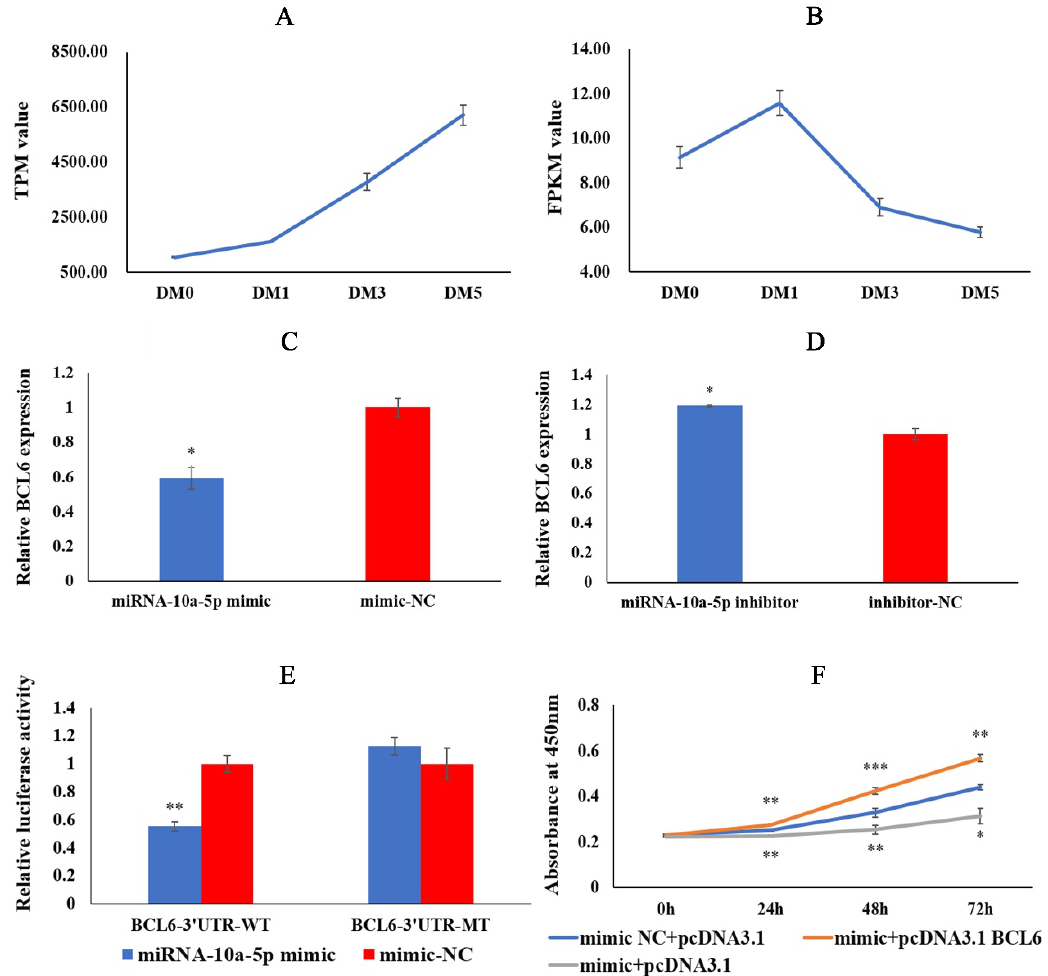
Figure 4. miRNA-10a-5p has a targeting relationship with BCL6. ( A , B ) DM0, DM1, DM3, and DM5 represent CMs that were induced to differentiate for 0, 24, 72, and 120 h, respectively. TPM is the abbreviation for Transcripts Per Million, and FPKM is the abbreviation for Fragments Per Kilobase per Million. ( C , D ) The relative expression of BCL6 after transfection with miRNA-10a-5p mimic and inhibitor. ( E ) The results of co-transfecting miRNA-10a-5p mimic and BCL6- 3′UTR -WT ； miRNA- 10a-5p and BCL6- 3′UTR -MT ； mimic-NC and BCL6- 3′UTR -WT ； and mimic-NC and BCL6- 3′UTR - MT in the dual-luciferase reporter assay. ( F ) Co-transfecting mimic-NC and pcDNA3.1 ； miRNA- 10a-5p mimic and pcDNA3.1-BCL6 ； and miRNA-10a-5p and pcDNA3.1 in the rescue assay. In all graphs, the results are shown as mean ± SEM (standard error of the mean) ( n = 3). * p < 0.05, ** p < 0.01, *** p <0.001.